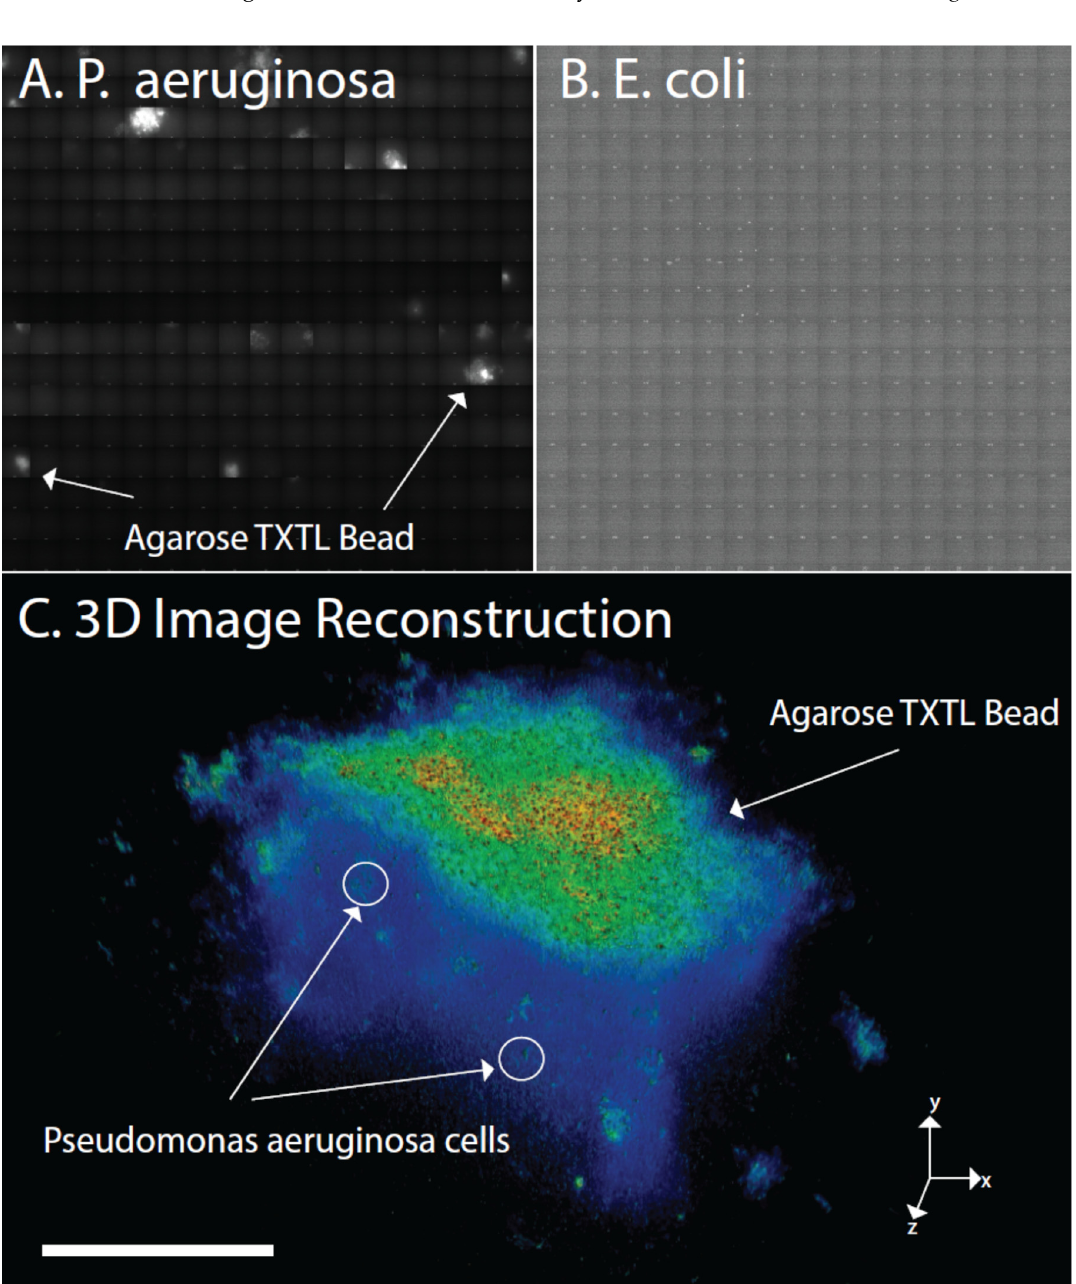
Figure 5. Imaging the sensing and reporting activities of agarose TXTL beads in cell cultures of ( A ), Pseudomonas aeruginosa ( B ), Escherichia coli control ( C ), 3D Reconstructed image of individual Pseudomonas aeruginosa cells and agarose TXTL bead (scale bar = 30 µm).